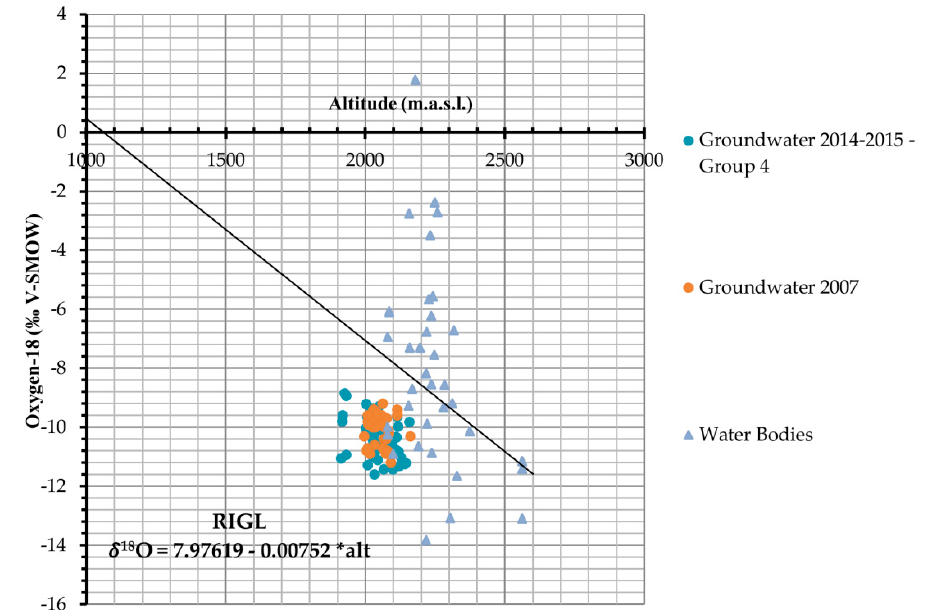
Figure 12. Estimation of the recharge elevation using δ 18 O versus elevation, the first RIGL (regional isotopic gradient line) for the region is also presented.